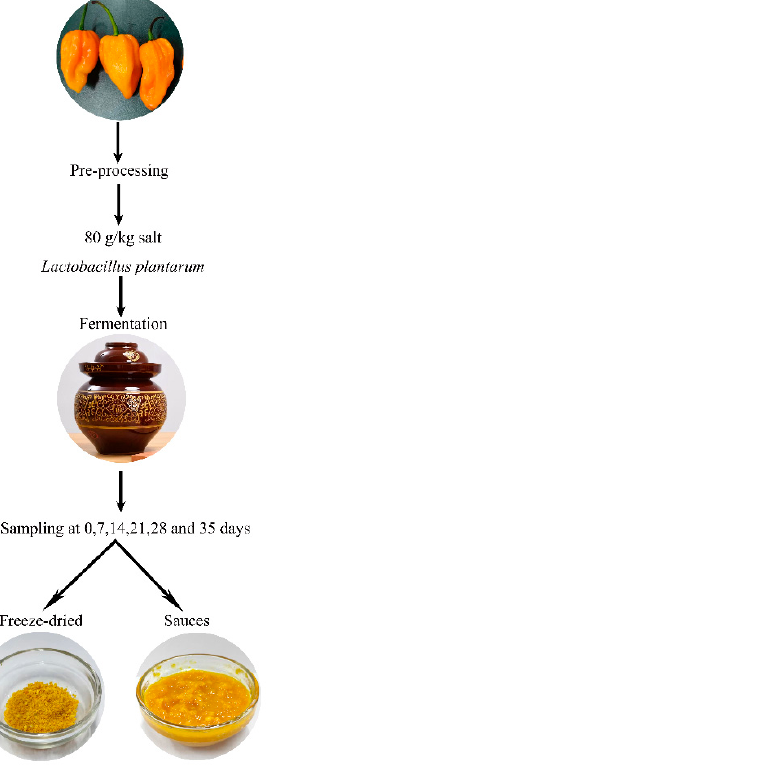
Figure 5. The preparation process of yellow lantern pepper sauce.